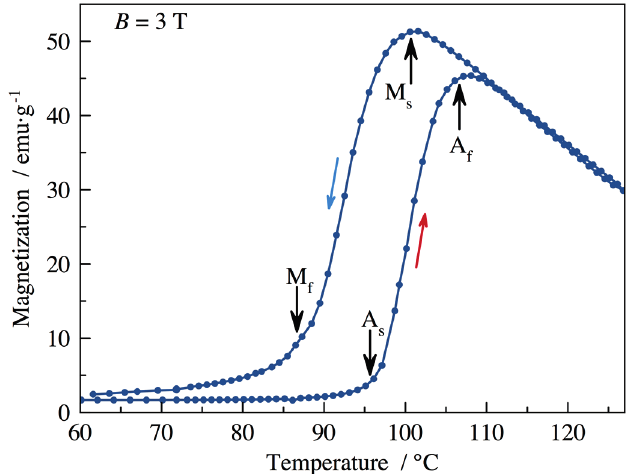
Figure 17. Thermo-magnetization characteristic of a Ni–Co–Mn–In film for a magnetic field of 3 T. The start and finish temperatures of forward and reverse transformation between martensite (M) and austenite (A) are indicated by